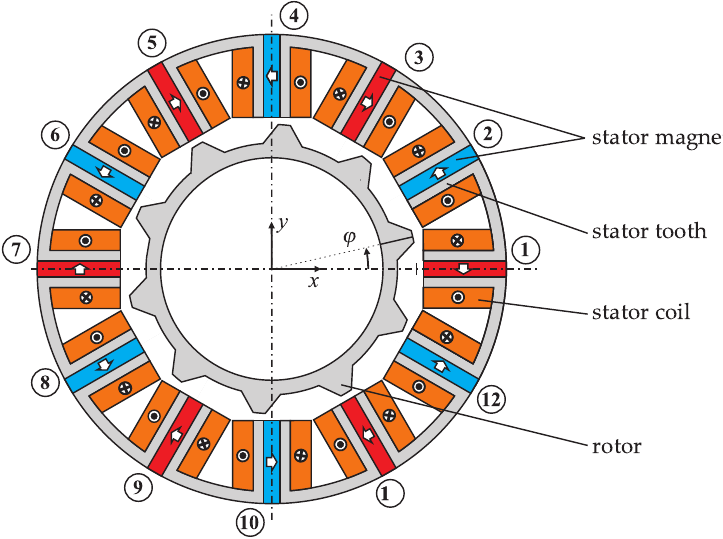
Figure 1. Cross-section of a flux-switching motor with twelve stator and 10 rotor teeth. The arrows indicate the direction of